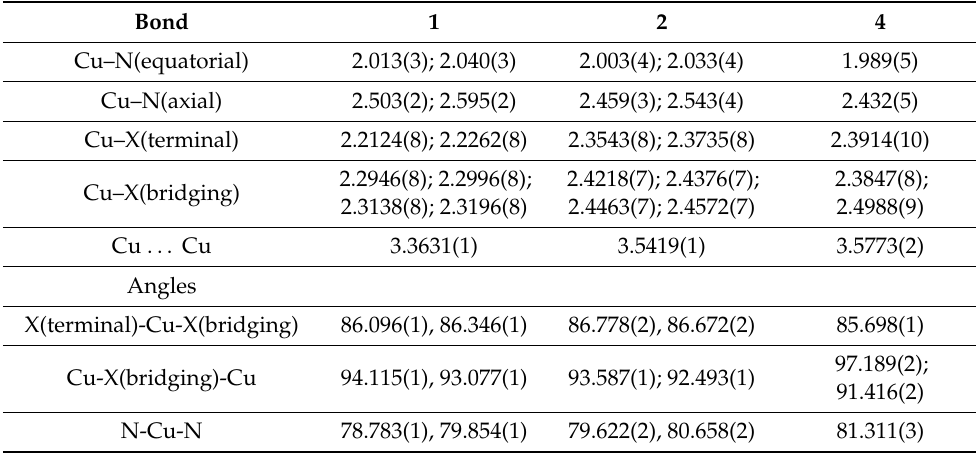
Table 1. Selected bond lengths (Å) and angles (°) for 1 , 2 and 4 .